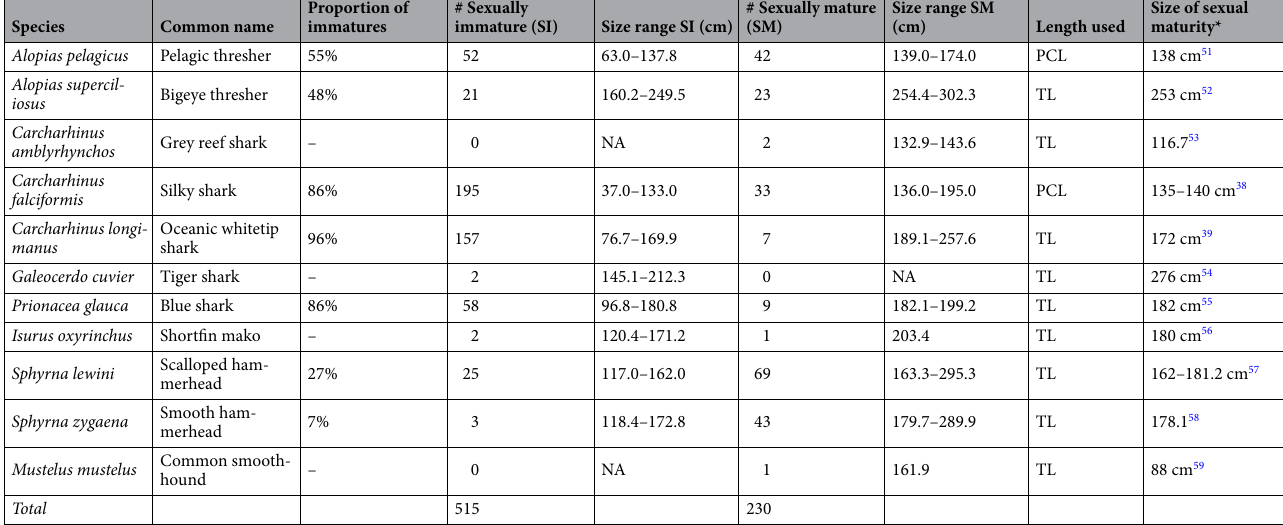
Table 2. Proportion of sexually mature individuals inferred from pre-caudal length. References are for studies reporting size for sexual maturity for males. PCL precaudal length, TL total